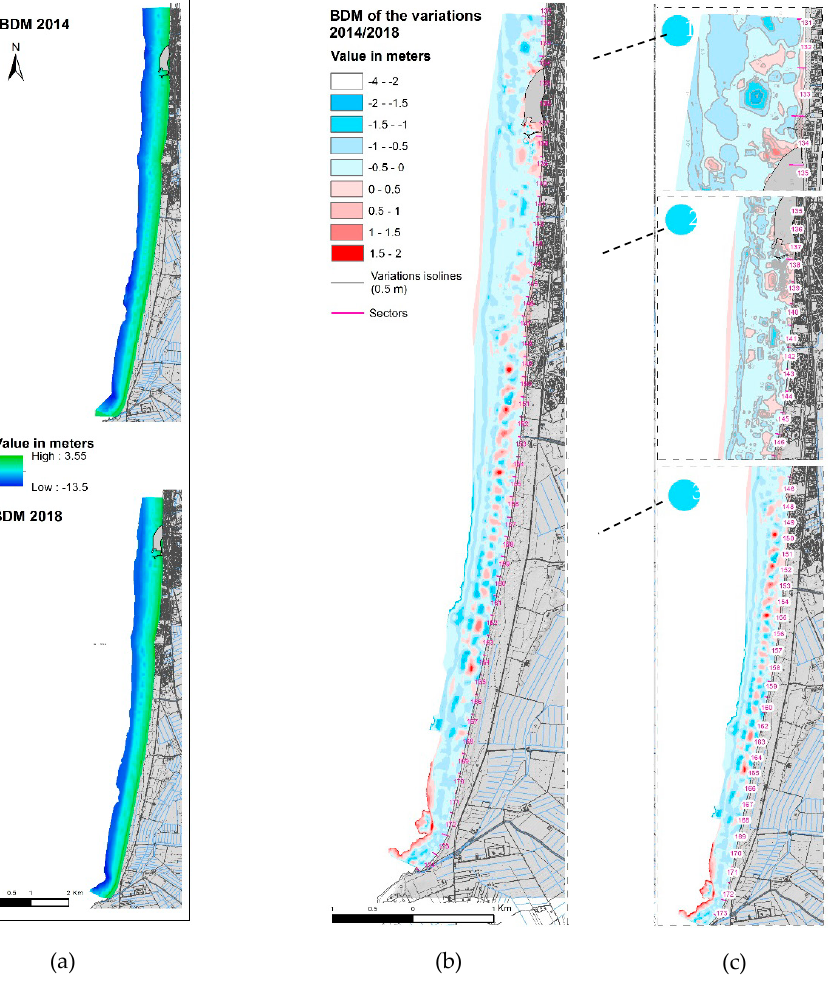
Figure 11. ( a ) Bathymetric digital model of the years 2014 and 2018; ( b ) differences in the seabed’s top surface registered between March 2014 and June 2018; ( c ) sketch maps of the subunits.